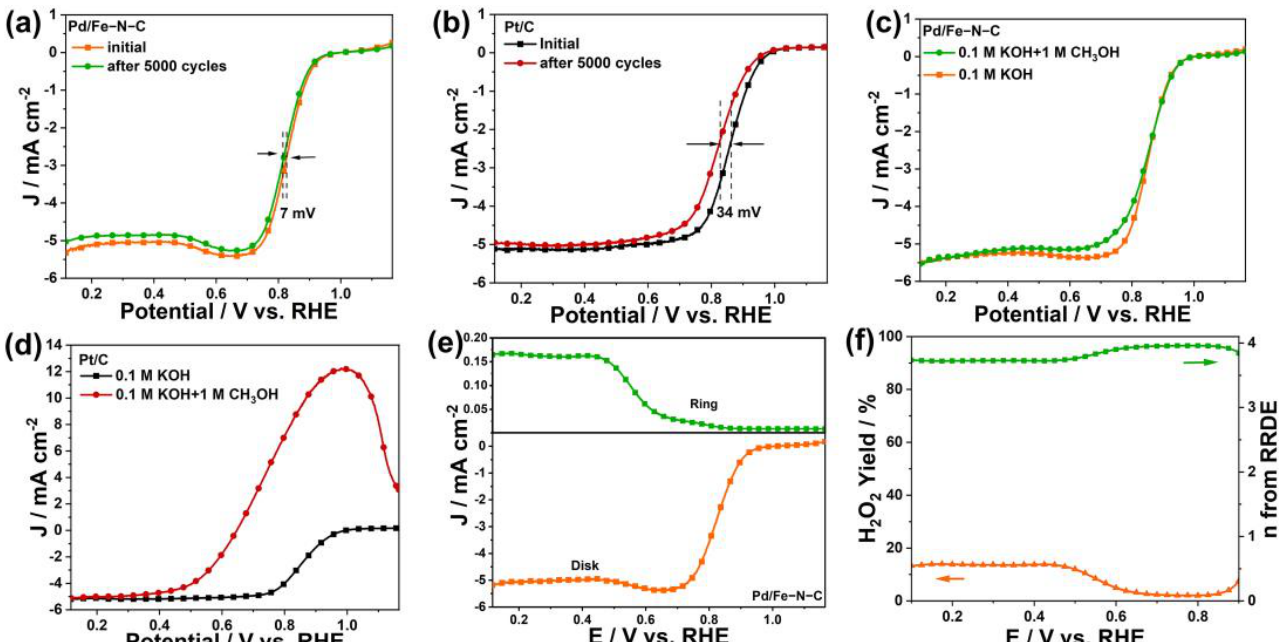
Figure 4. LSV curves before and after the ADT test with 5000 CV cycles for ( a ) Pd/Fe−N−C and ( b ) commercial Pt/C. LSV curves before and after the addition of 1.0 M CH 3 OH for ( c ) Pd/Fe−N−C and ( d ) commercial Pt/C. ( e ) LSV curves recorded on the RRDE for Pd/Fe−N−C in an O 2 −saturated 0.10 M KOH solution at 1600 rpm. ( f ) Calculated H 2 O 2 yield and electron transfer numbers (n) for Pd/Fe−N−C.